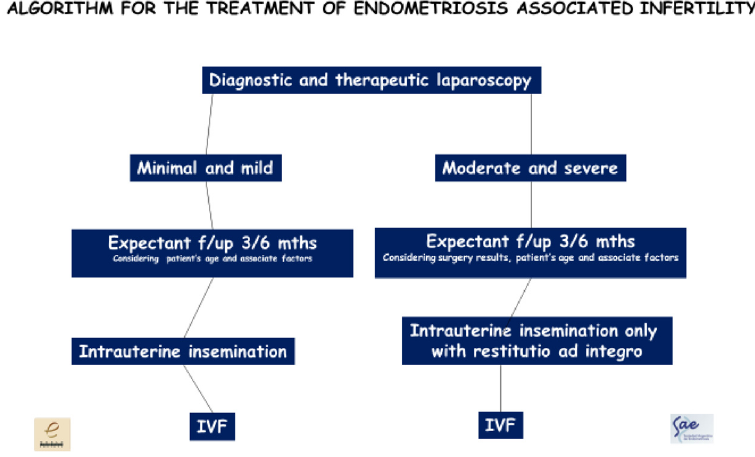
Figure 6. Algorithm proposed by the author for the treatment of endometriosis-associated infertility. This algorithm is proposed in cases where laparoscopy is indicated for endometriosis-associated infertility. Many patients with suspected endometriosis benefit directly from assisted reproductive techniques without a prior laparoscopy. IVF, in vitro